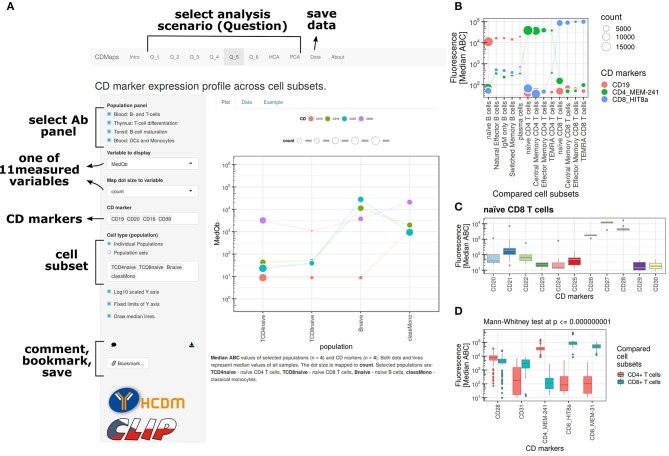
Overview of the CD Maps web resource available at hcdm.org. (A) The user interface allows for interactive data interrogations. The resource uses several scenarios for data exploration and allows for data download, bookmarking of analysis state, and image export. Analysis examples: (B) paired analysis of CD marker expression on cell subsets, e.g., in a differentiation setting. (C) Visualization of expression of multiple CD markers including a measure of variation for a single subset. (D) Analysis and visualization of statistically differentially expressed CD markers between two subsets or two groups of cell subsets.